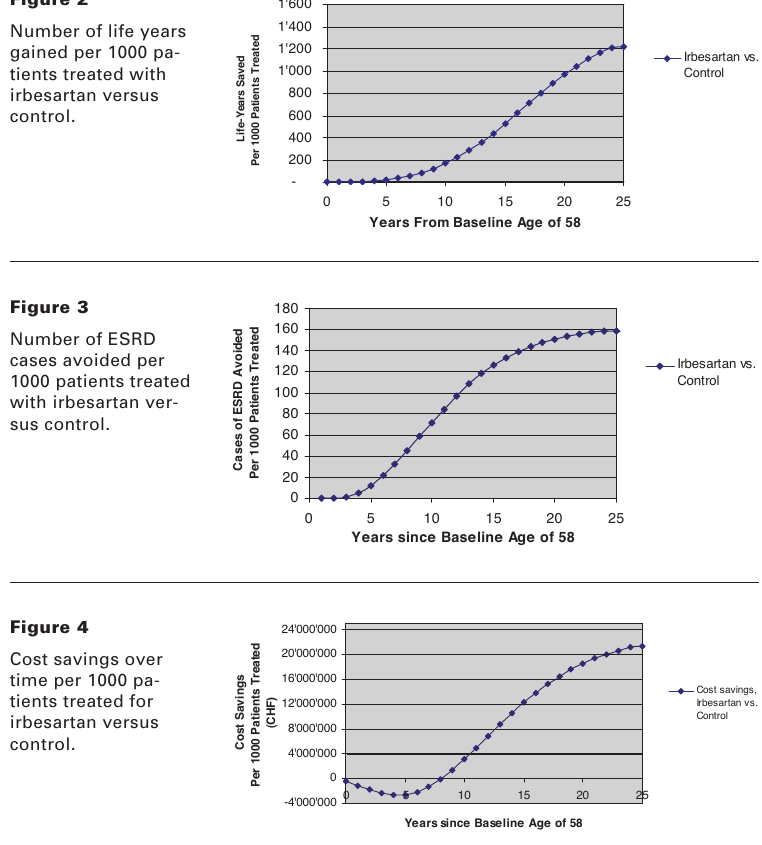
Cost savings, Irbesartan vs. Control